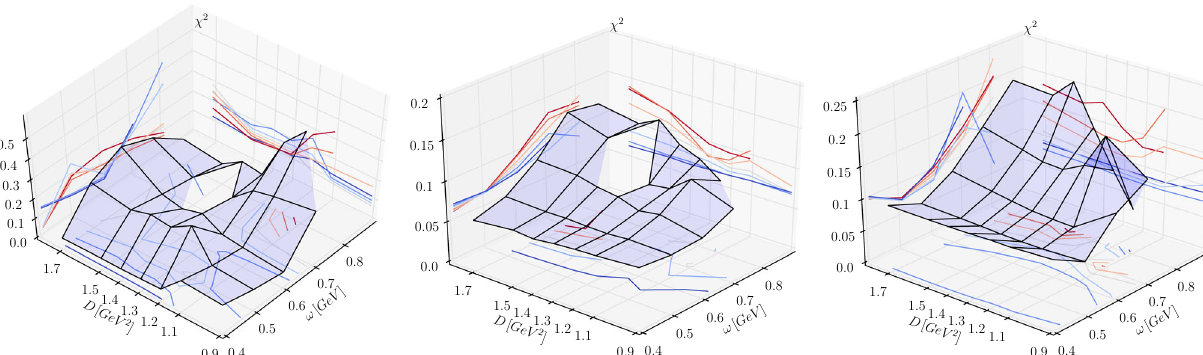
Fig. 17 χ 2 plot from the comparison of our calculated and the experimental radial splitting as a function of ω and D . Left panel Combination of all ground-first-excitedradialsplittings(seetext);centerpanelcombinationofasubsetof5splittings(seetext);rightpanel ( [ 0 −+